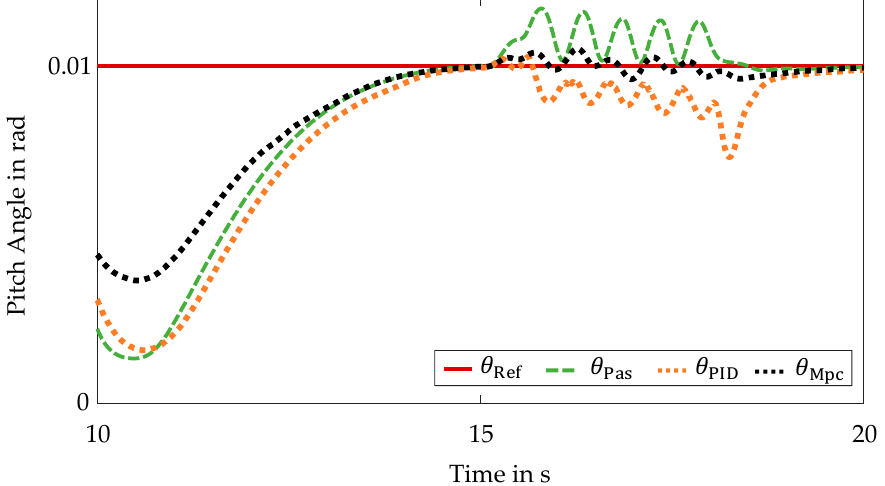
Figure 11. Control Quality Sinusoidal Steering–Pitch Behavior–Pitch Angle Curves. The positive influence of central predictive control is likewise evident during the sinusoidal steering. Compared to the passive vehicle and the conventional control approach, the pitching movements are reduced.